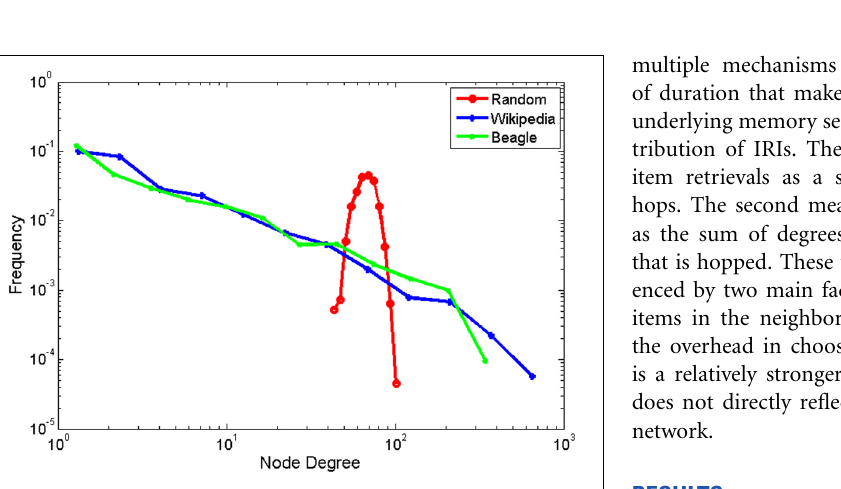
FIGURE 2 | Probability distributions for node degrees for the Wikipedia animal network, Beagle animal network, and scrambled control network. Data are binned logarithmically, and shown in double logarithmic